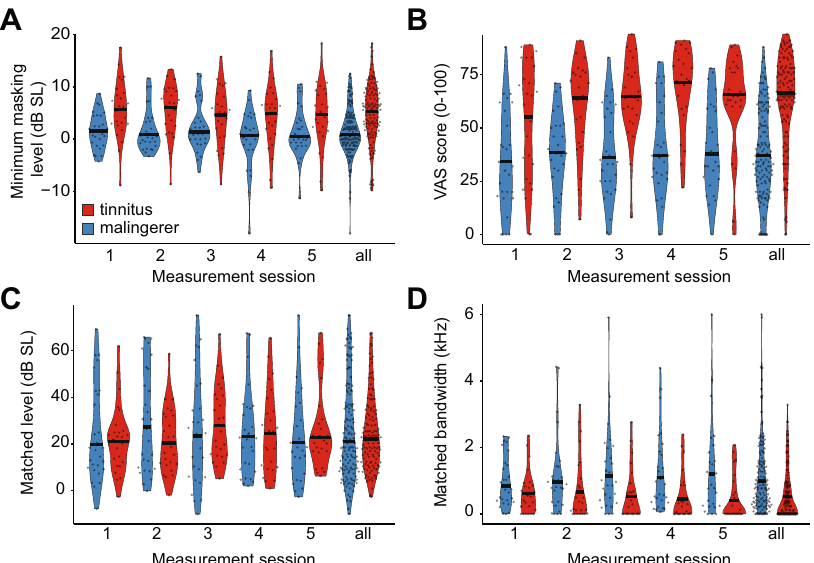
Fig. 1 Mean behavioral tinnitus characterization for the patient and malingering group. Normalized density distributions along with single participant data ( fi lled circles) are provided for MML ( A ), VAS ( B ), loudness matching ( C ) and bandwidth matching ( D ). All estimates were repeated fi ve times, shown individually and collapsed over all sessions. Black lines indicate the mean score, and black dots correspond to individual participants. In our population, malingering participants report that their imagined tinnitus is less tonal, more easily masked, and less bothersome than participants with tinnitus.